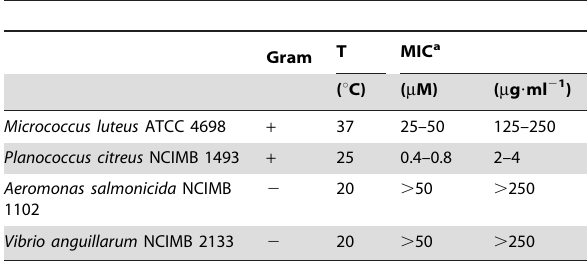
Table 3. Antibacterial activity of recombinant cod beta-